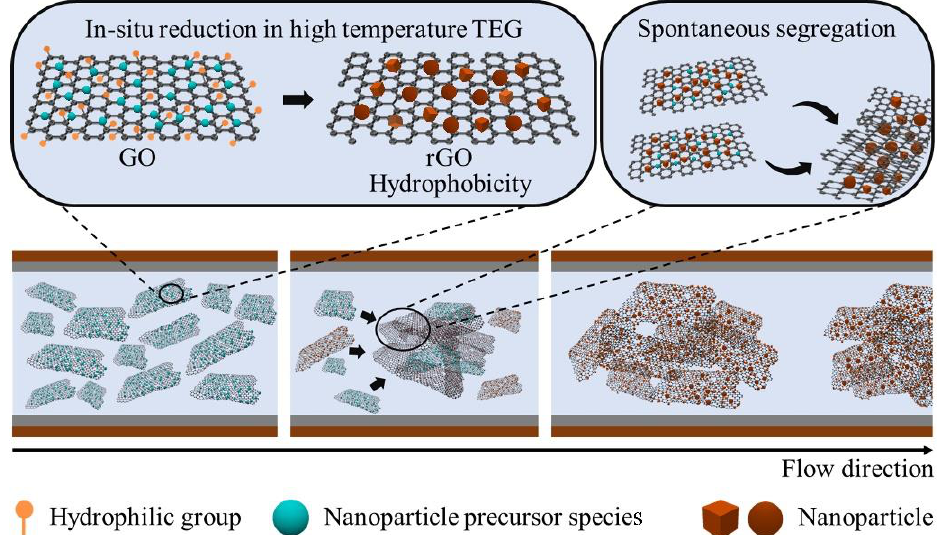
Figure 1. Schematic illustration of the major evolution steps involved spontaneous phase segregation of rGO-supported nanocrystal agglomerates during the simultaneous formation of nanocrystals and reduction of GO in hot polyols.